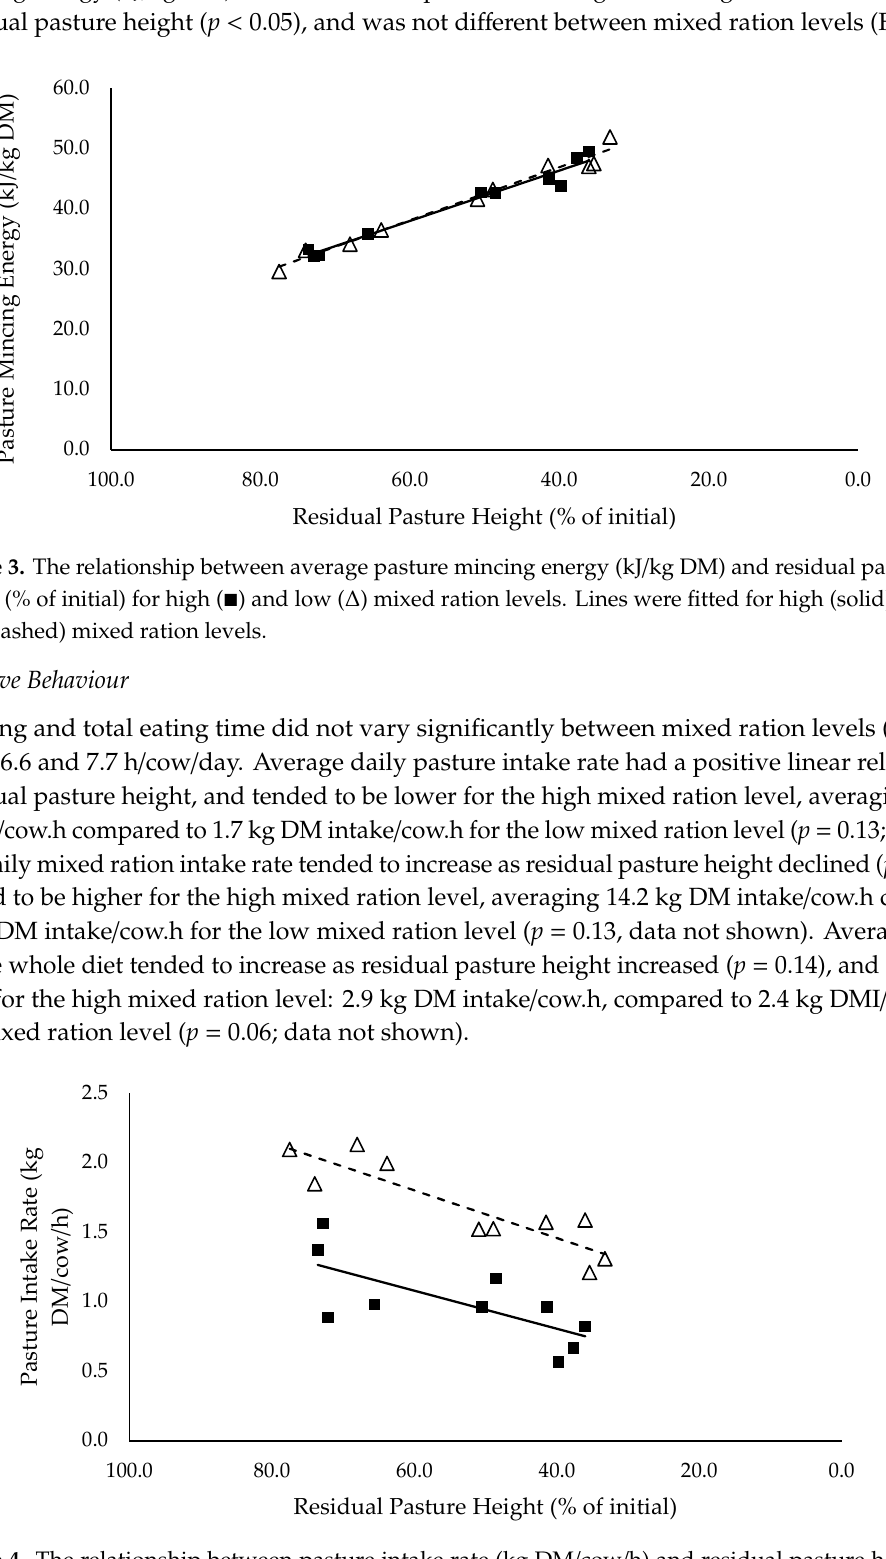
Figure 4. The relationship between pasture intake rate (kg DM/cow/h) and residual pasture height (% of initial) for high ( ■ ) and low (Δ) mixed ration levels. Lines were fitted for high (solid) and low (dashed) mixed ration levels.